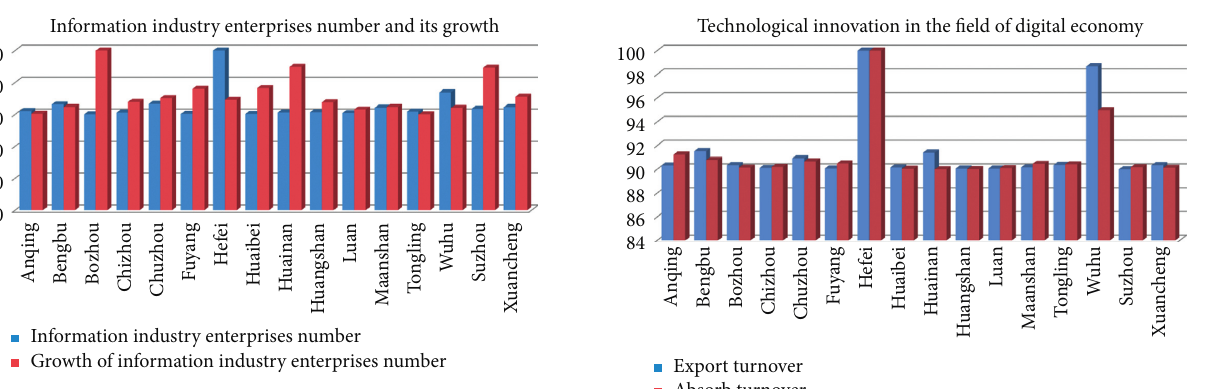
Figure 6: Information industry enterprises number and its growth.